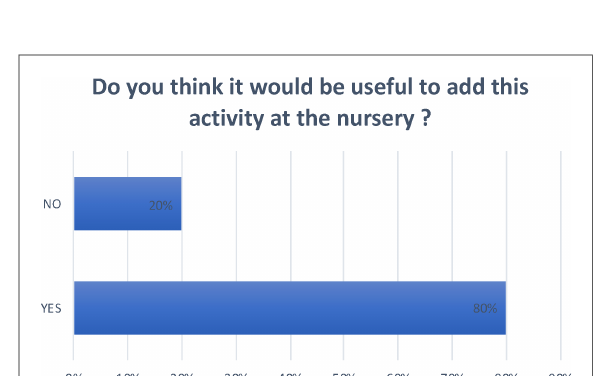
FIGURE 7 If toothpaste is used, how do you manage rinsing?